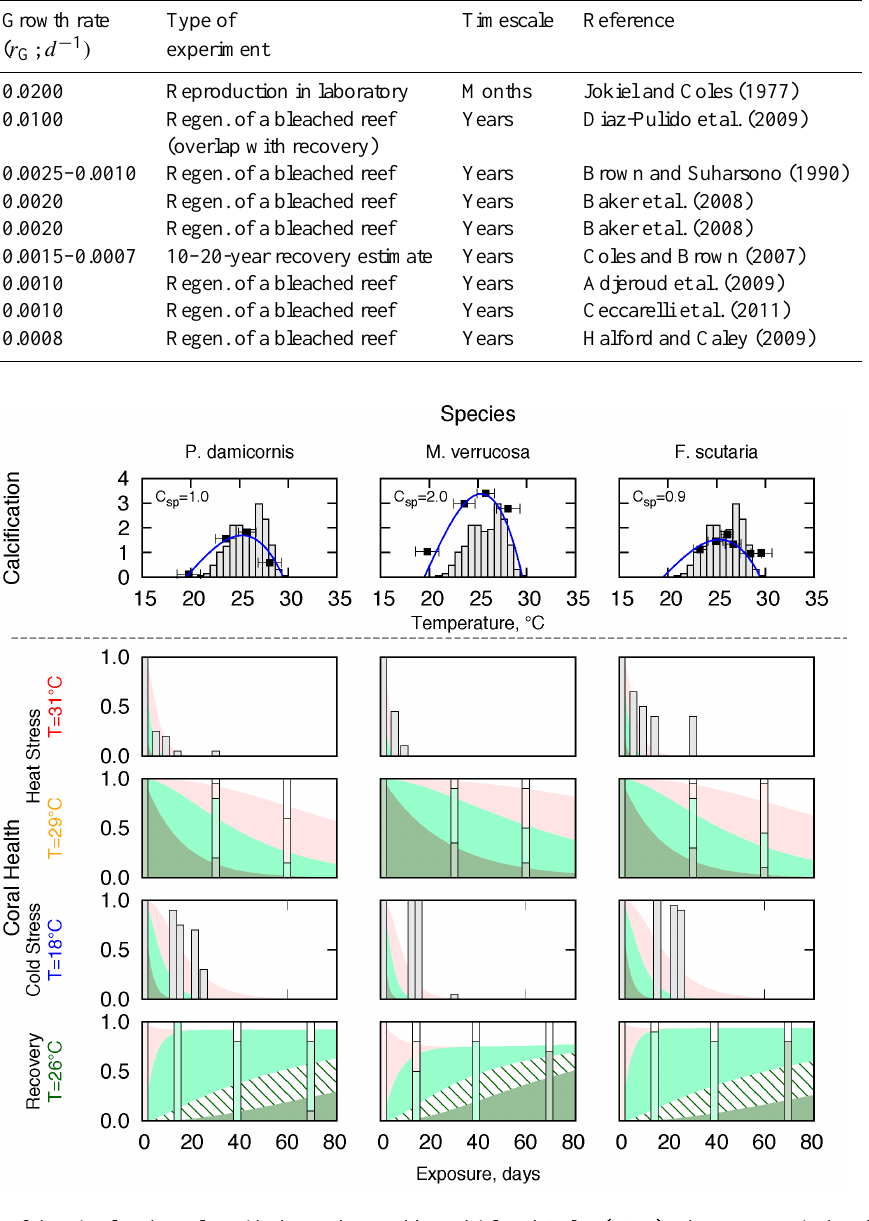
Figure 3. Comparison of the simulated results with those observed by Jokiel and Coles (1977). The first row is the observed calcification rates (box and whiskers), the histogram of temperatures (grey boxes) and the adapted response curve (blue line). The lower 4 rows show the observations of coral health as bars. When coral health was reported the bars are coloured as in Fig. 2, otherwise when only the total population was reported the bars are coloured grey. The model results are shown as continuous fill using the colour scheme of Fig.